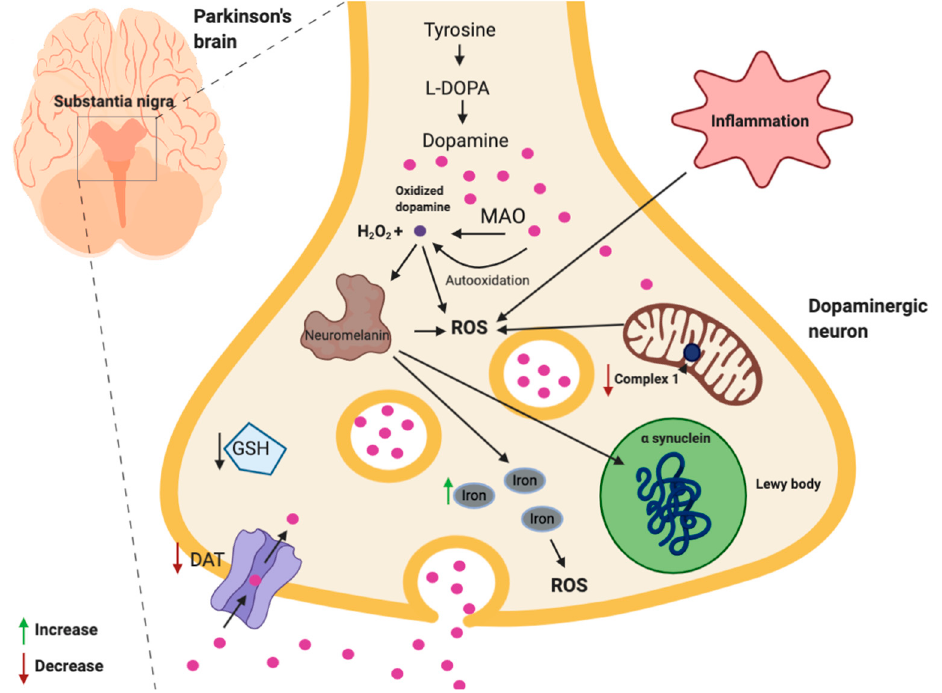
Figure 3. Schematic representation of ROS sources and their molecular targets in PD. Image created with BioRender.com.